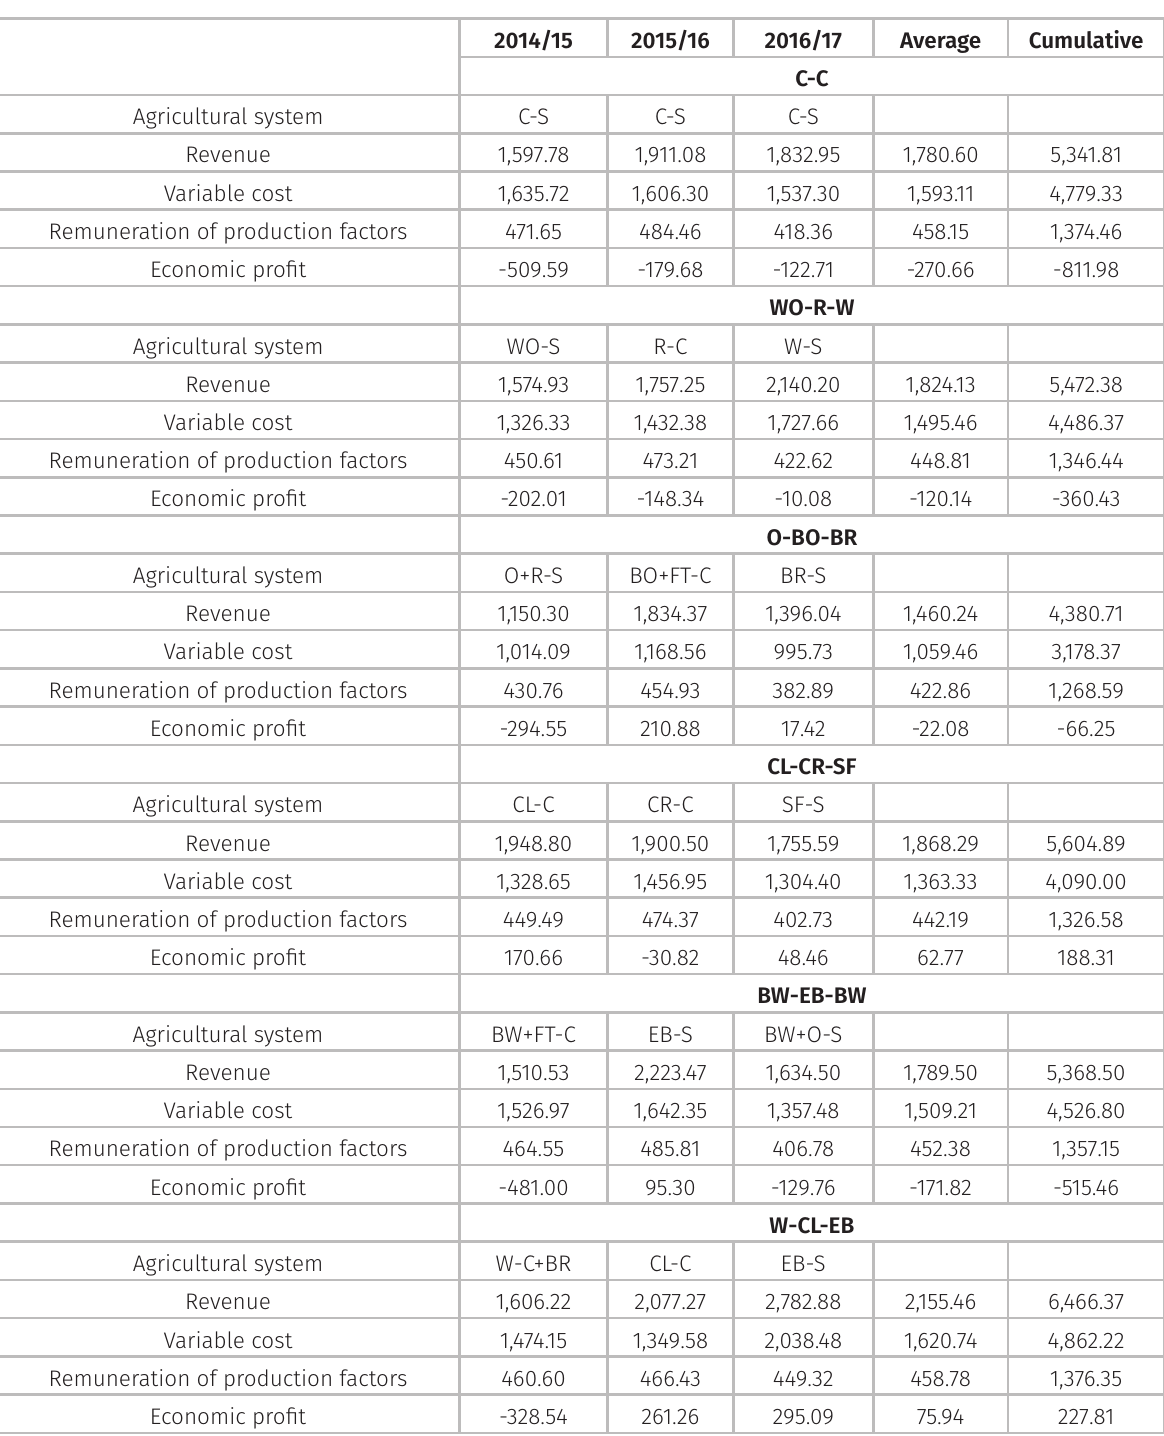
Table IV. Opportunity cost and economic profit (US$ ha - ¹) of the production systems for the 2014/15, 2015/16, and 2016/17 crop